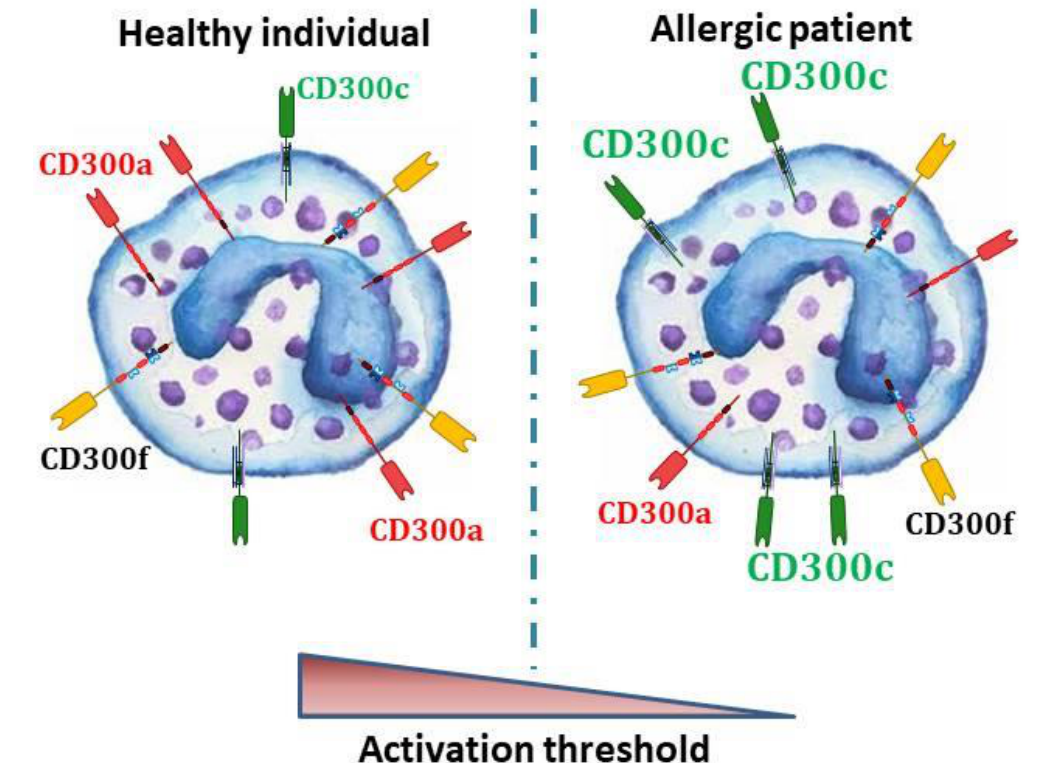
Figure 1. In human basophils, IgE-dependent activation is regulated, among others, by CD300 activating and inhibitory receptors. In allergic individuals, a lower expression of the CD300a inhibitory receptor [57] and a higher expression of CD300c activating receptor [53,58] have been described. Therefore, it could be postulated that in allergic people, the unbalance in the CD300 mediated signals may lead to a lower Fc ε RI activation threshold.